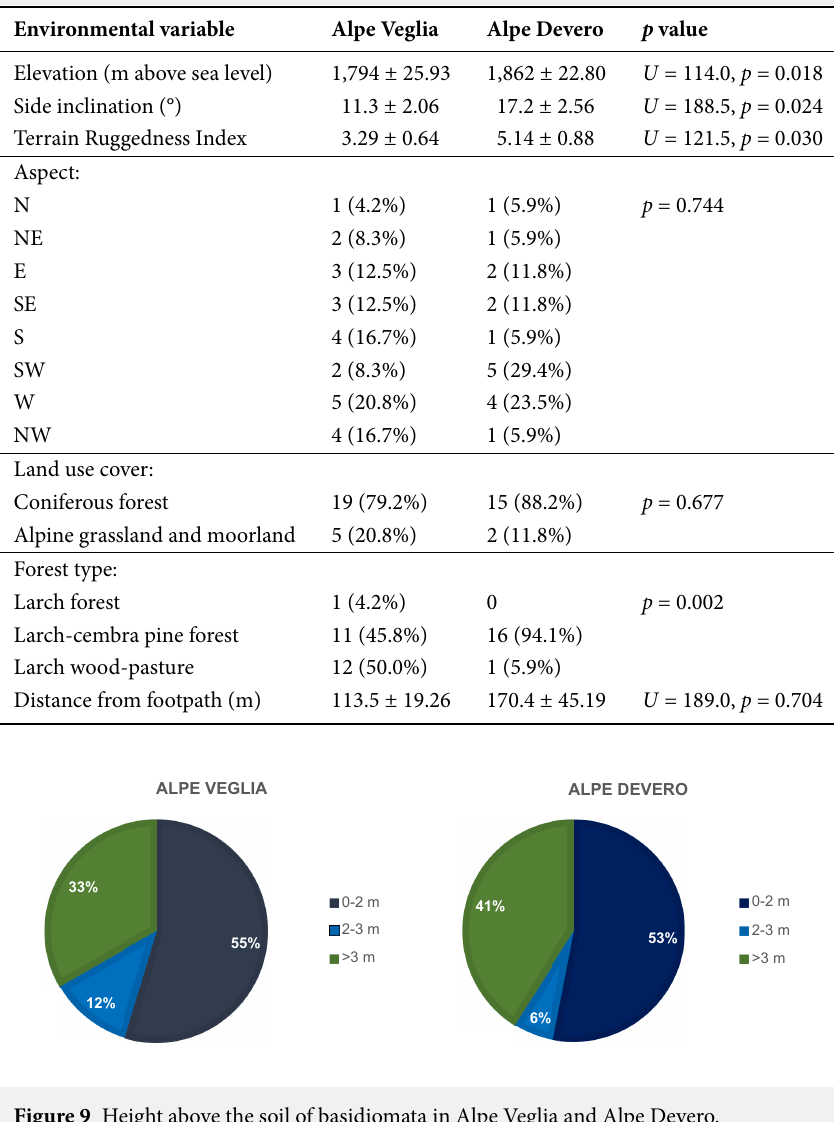
Figure 9 Height above the soil of basidiomata in Alpe Veglia and Alpe